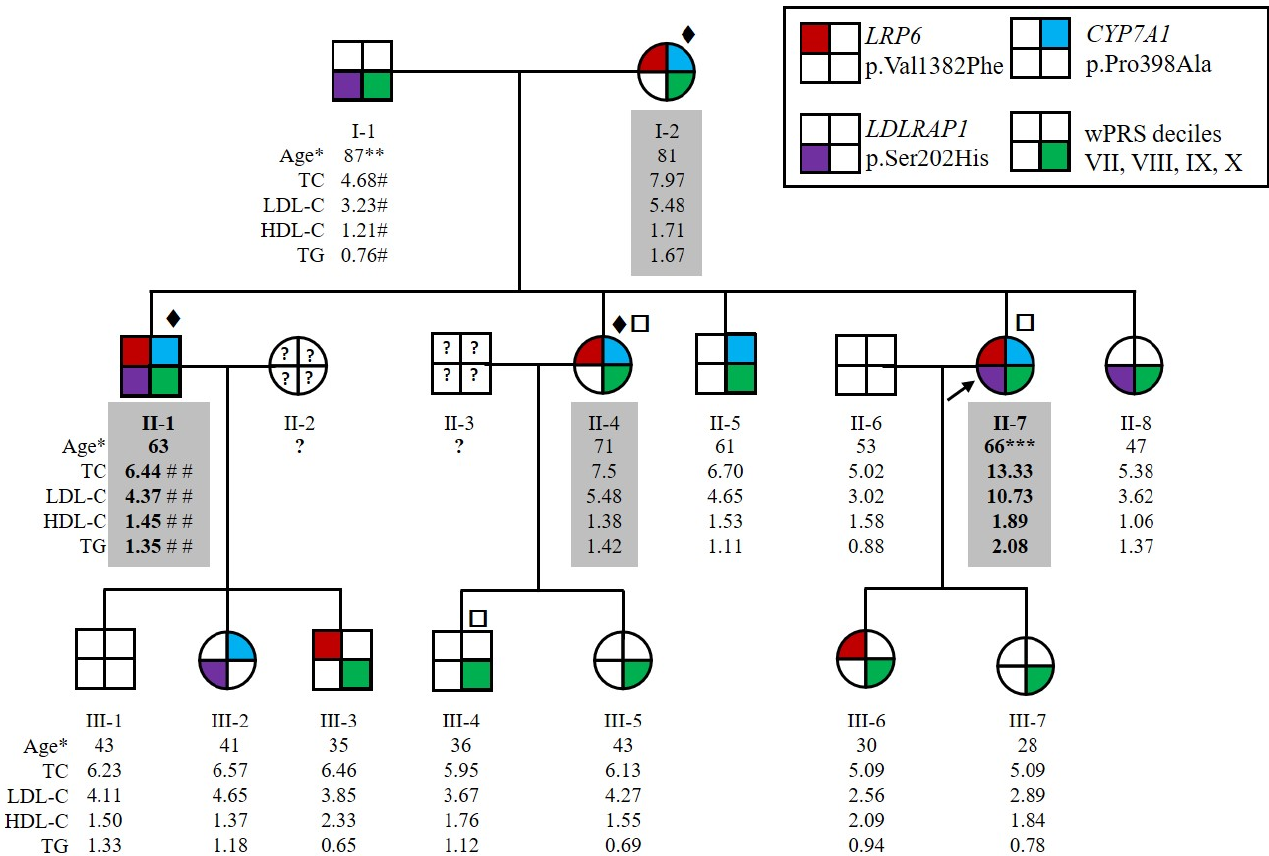
Figure 1. Pedigree of the family HC438 with the segregation of p.(Val1382Phe) variant in LRP6 , p.(Pro398Ala) variant in CYP7A1 and p.(Ser202His) variant in LDLRAP1 and the weighted Polygenic Risk Score (wPRS). The proband II-7 is indicated by the black arrow. Squares and circles represent men and women, respectively. Affected family members are indicated by values highlighted in gray. More severely affected family members are indicated by bold values. * Age at lipid measurement in years. ** Myocardial infarction at 75 years old. *** Severe atheroma. # Under ciprofibrate. ## Under 5 mg rosuvastatin treatment. Patients for whom ♦ whole exome, □ whole genome sequencing was performed. Lipid values in mmol/L: TC for total cholesterol; LDL-C for LDL cholesterol; HDL-C for HDL cholesterol; TGs for triglycerides.